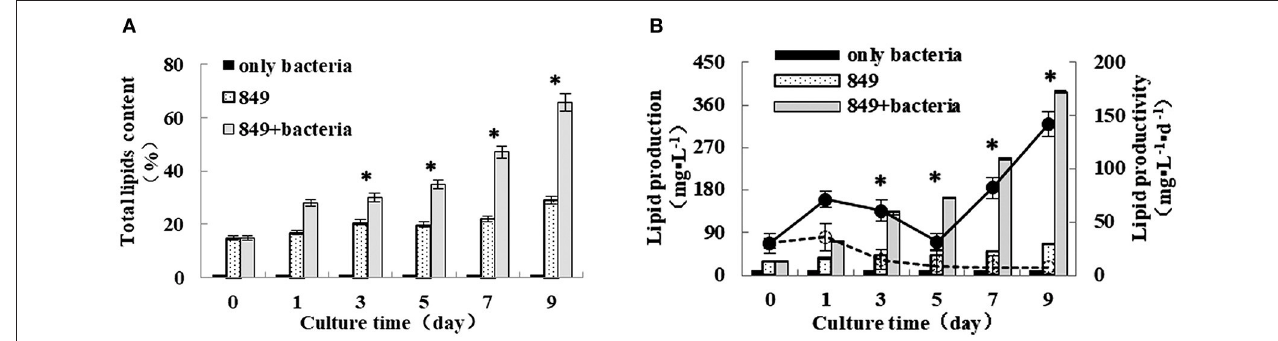
FIGURE 5 | (A) Lipid content (B) lipid production and lipid productivity of algae in the co-culture were measured on days 0, 1, 3, 5, 7, and 9 after incubation in a nitrogen-deprived medium. Pure algae culture was used as the controls. Lipid content and lipid production are shown with bars and lipid productivity of algae in the co-culture are shown with solid and dashed lines, respectively. *significant difference between the experimental and control groups. The vertical bars indicate standard errors calculated from at least three independent